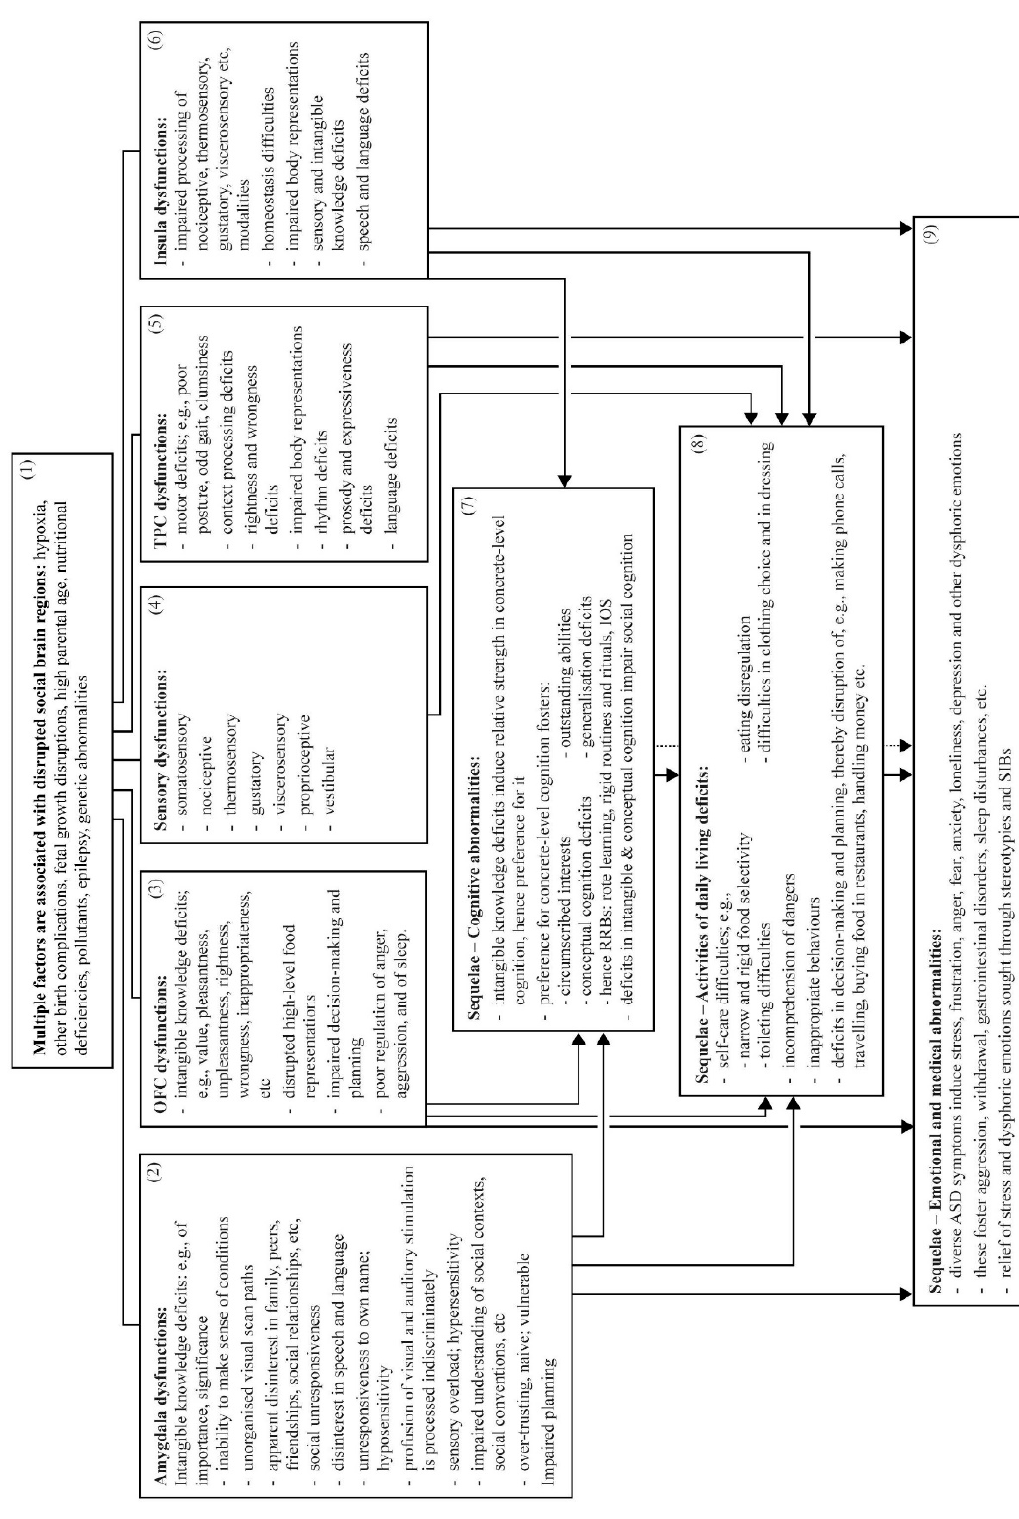
Figure 2. Disruption of four social brain regions extensively explains ASD symptomatology. Multiple factors are causally associated with ASD, and presumably disrupt assembly of social brain regions and circuits. ASD, autism spectrum disorders; IOS, insistence on sameness; OFC, orbitofrontal cortex; RRBs, restricted repetitive behaviors; SIBs, self-injurious behaviors; TPC, temporoparietal cortex. 3. Neurocircuitry: The Four Social Brain Regions are Commonly Disordered in ASD